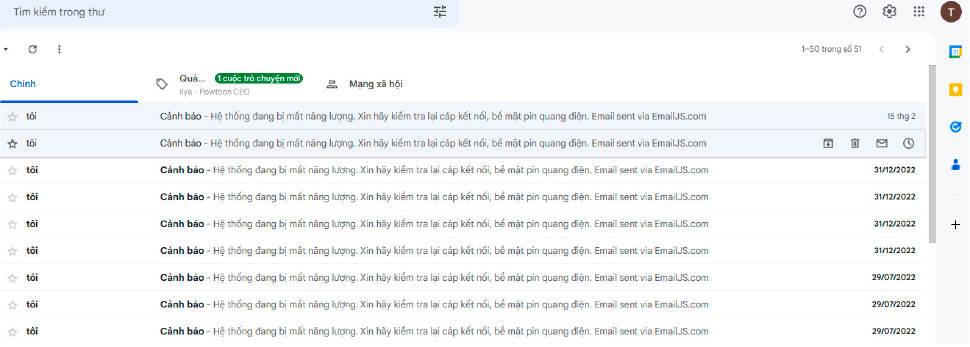
Figure 11. Screenshot of email interface for warning. Table 4. Comparison of fault detection function for PV